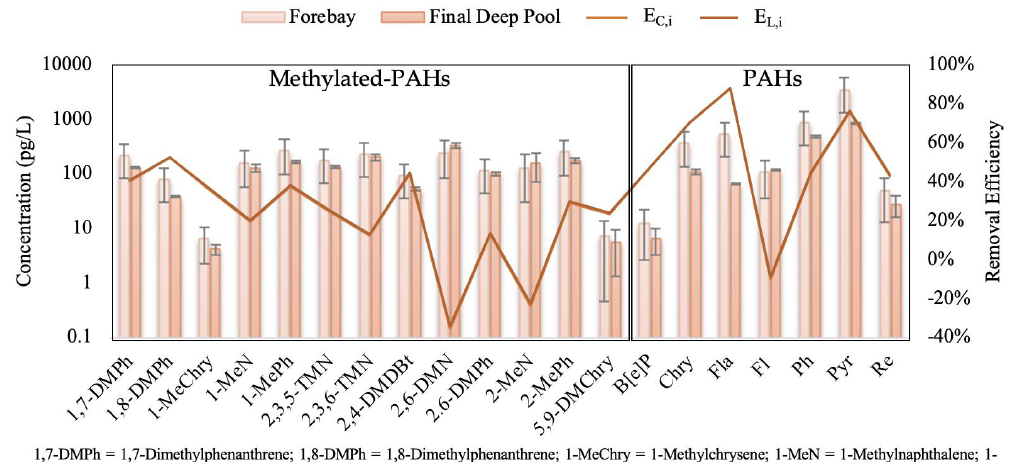
Figure 2. Dissolved aqueous concentrations and removal efficiencies of PAHs in the Kearl Treatment Wetland during deployment one (2017A). Error bars represents standard errors of the mean.